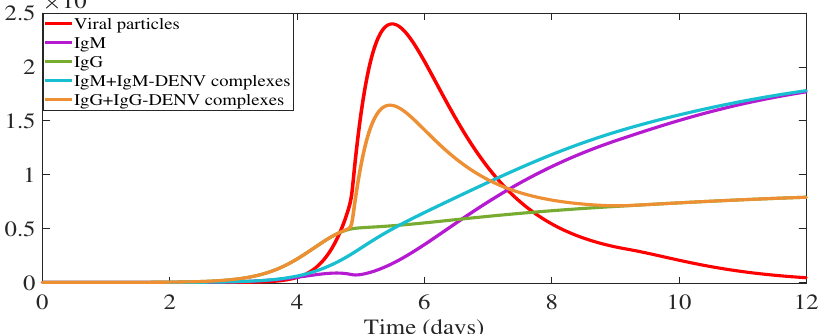
Figure 9. Model simulation: secondary dengue infection with a heterologous dengue serotype. Viral particles encountered as free viruses and complexes ( V + 4 · IgM-DENV+ IgG-DENV). Free IgM is shown in violet and free IgG in green. Antibody–virus complexes, IgM-DENV and IgG-DENV, are shown in blue and orange, respectively. The initial values are set the same as previous